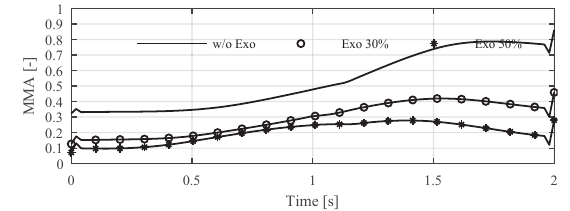
Figure 13: Maximum muscle activity (MMA) in the collective muscles of the upper body during the overhead reach Table 5: Mean muscle activation expressed with equiv- alent joint torques and maximum muscle ac-